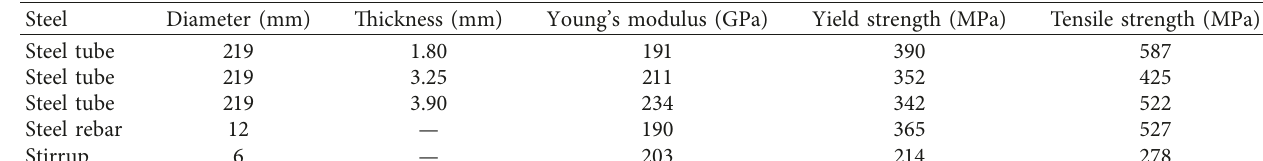
Table 3: Material properties of steel.